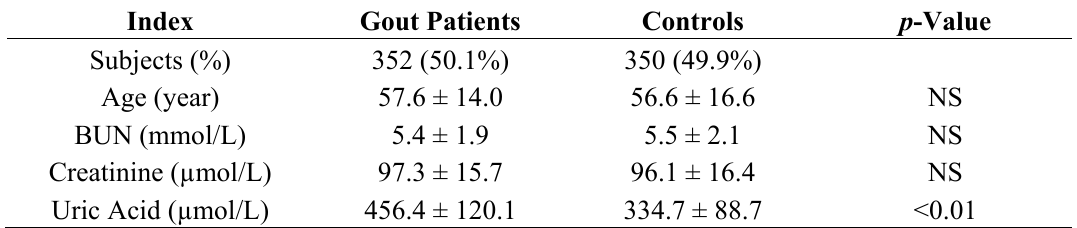
Table 4. Clinical and biochemical profile of gout patients and